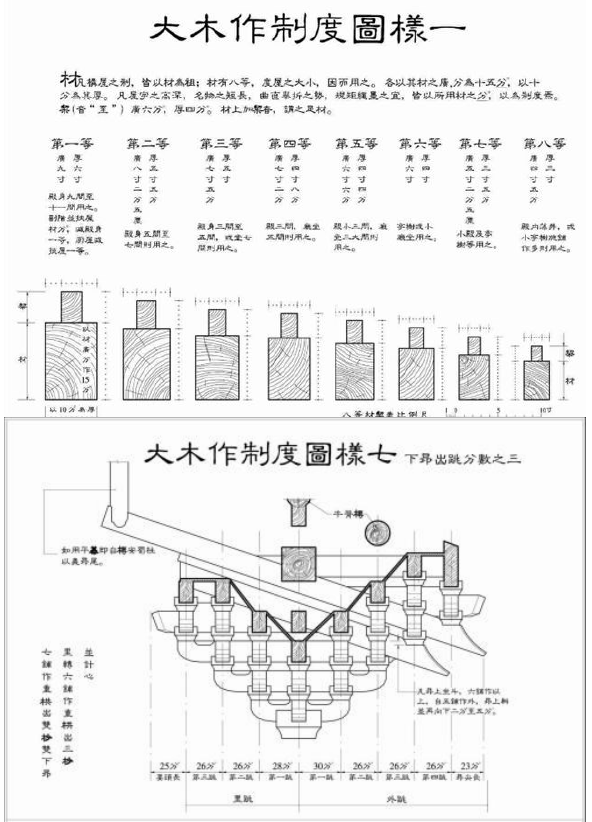
Figure 2. the Corner Bracket Set of Timber